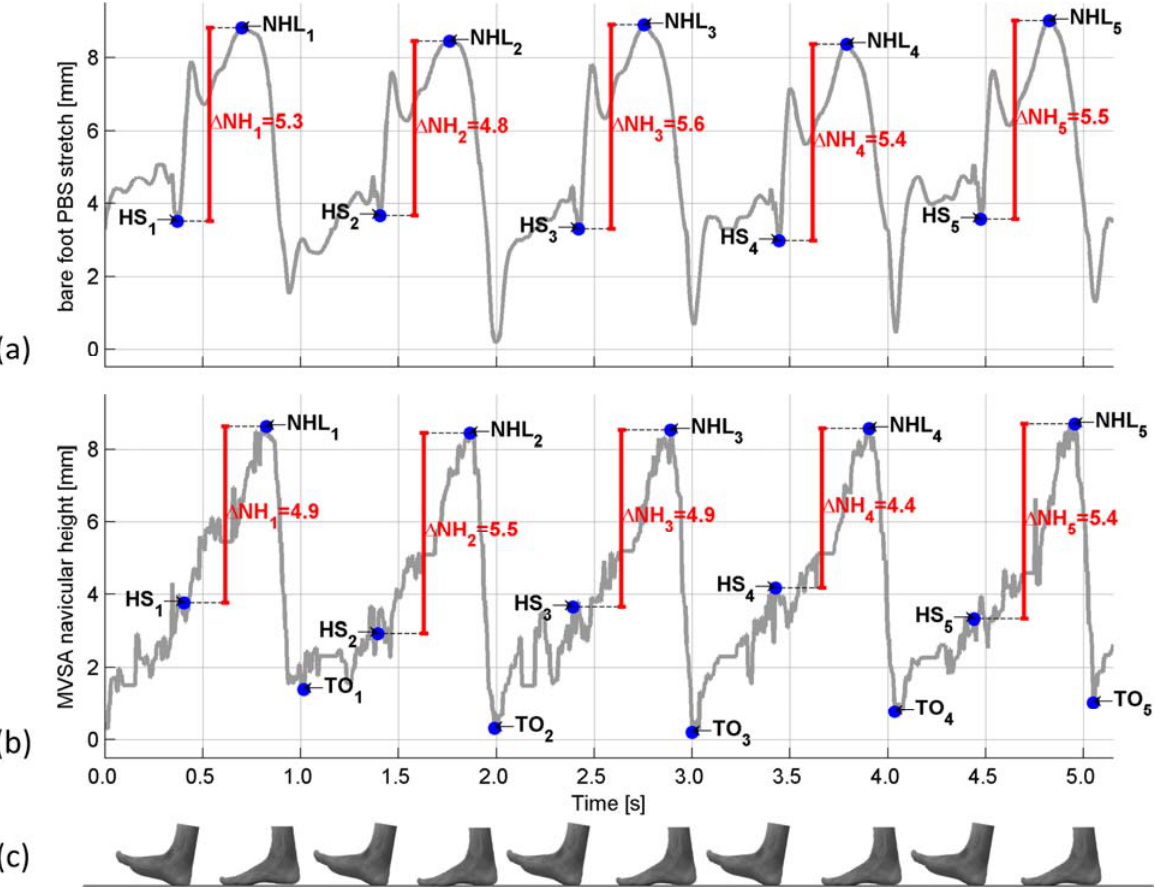
Figure 7. Measurements of the navicular height. The MVSA system and the PBS system are synchronized in time, using the method described in Section 2.3 ( a ) Bare foot measurement of the navicular drop using the PBS system; ( b ) Bare foot measurement of the navicular drop using the MVSA. The MVSA measurements are additive inverted, for easier comparison with the PBS measurements; ( c ) Foot indicating the stage of